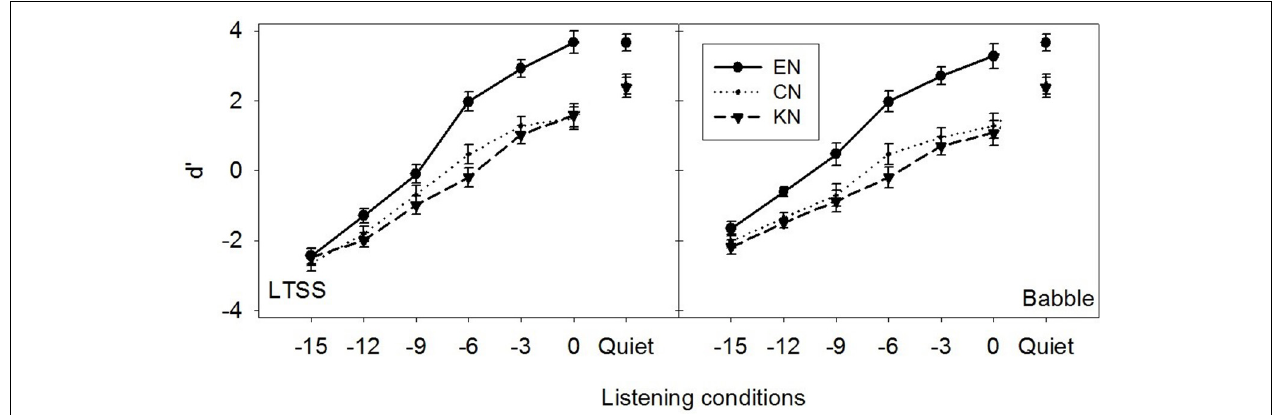
FIGURE 2 | Average d (cid:2) and standard errors over 12 vowels as a function of listening conditions in LTSSN (left) and MTB (right) for three listener groups (EN,CNandKN). Thed (cid:2) wascomputedasthedifferencebetweenthez-transformofhitsandthez-transformoffalsealarmforeachvowelandlisteningcondition.